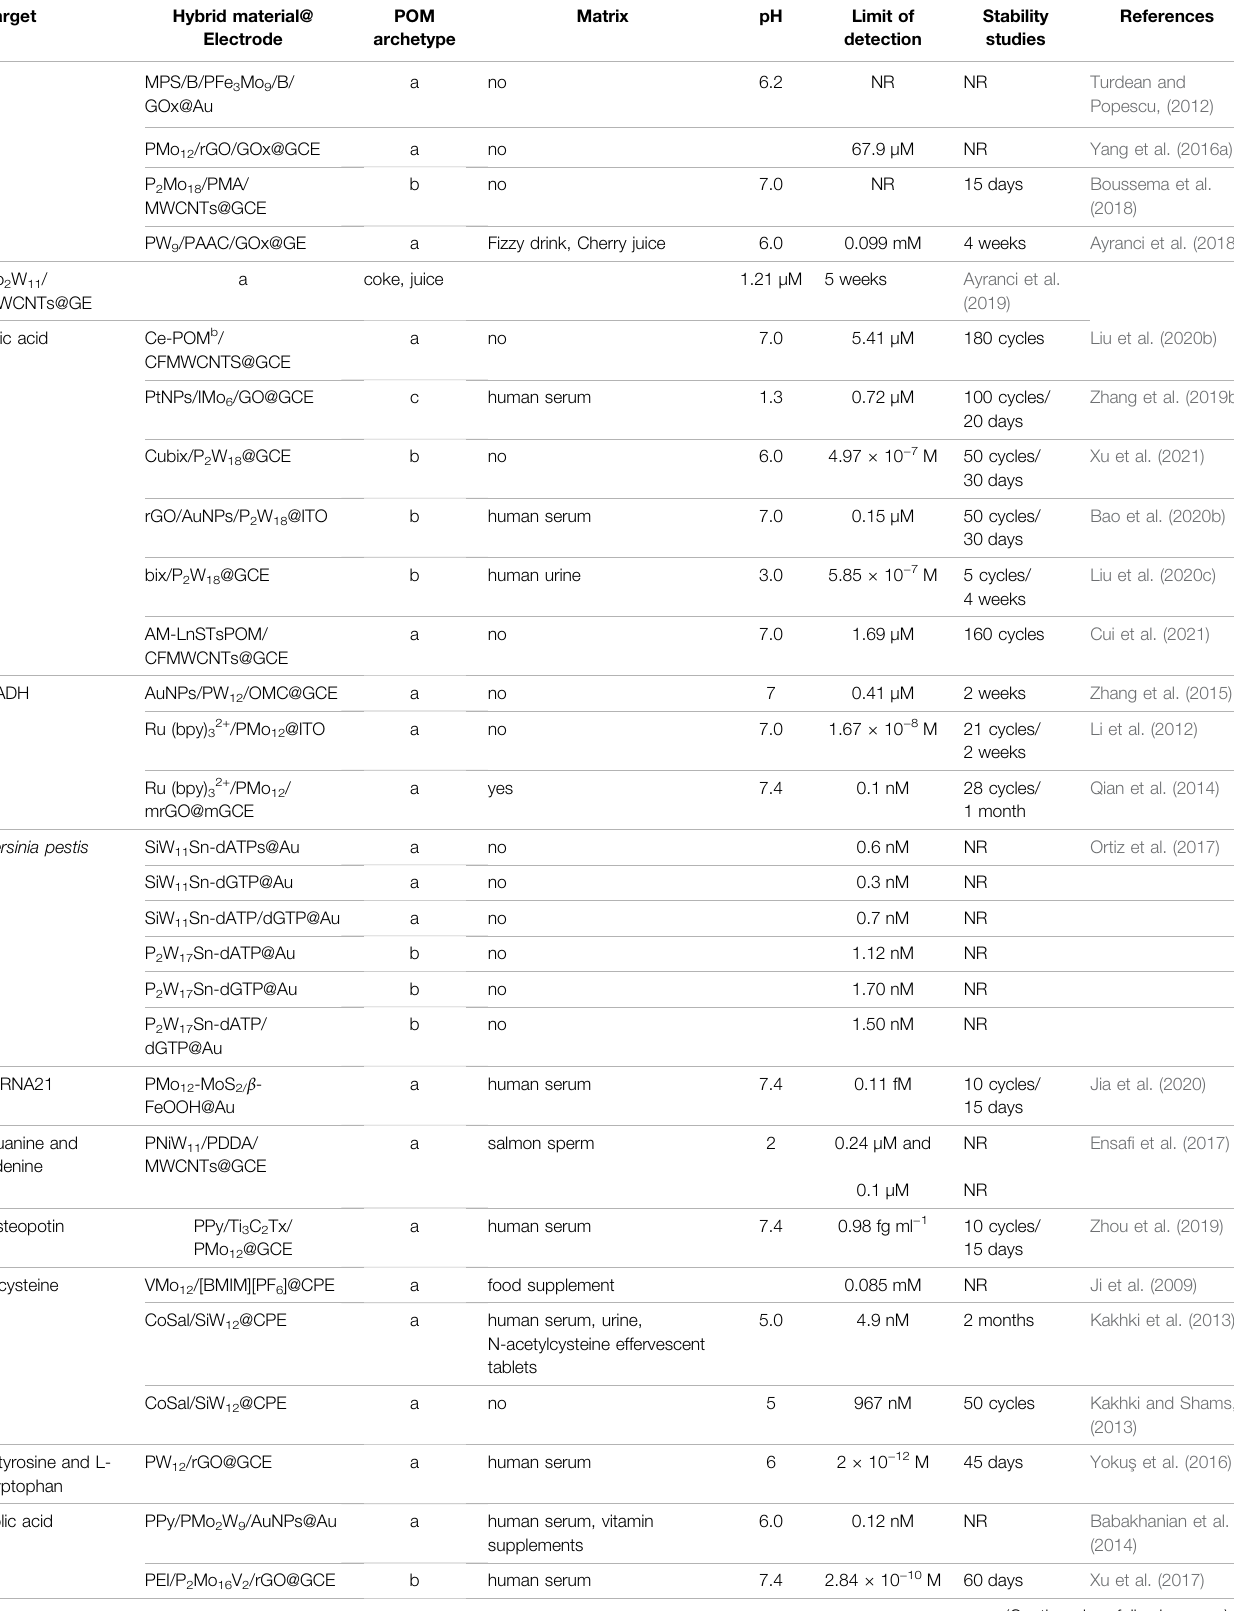
TABLE 4 | ( Continued ) POM-based electrochemical sensors for biomolecules and bio-related species.